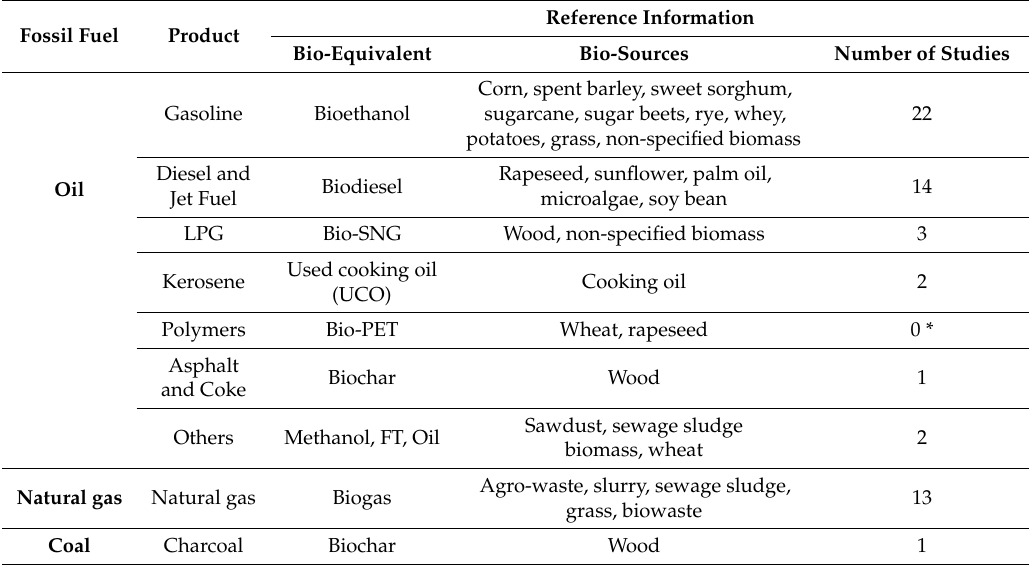
Table 1. Summary of data identified in literature review per fuel product. Adapted from